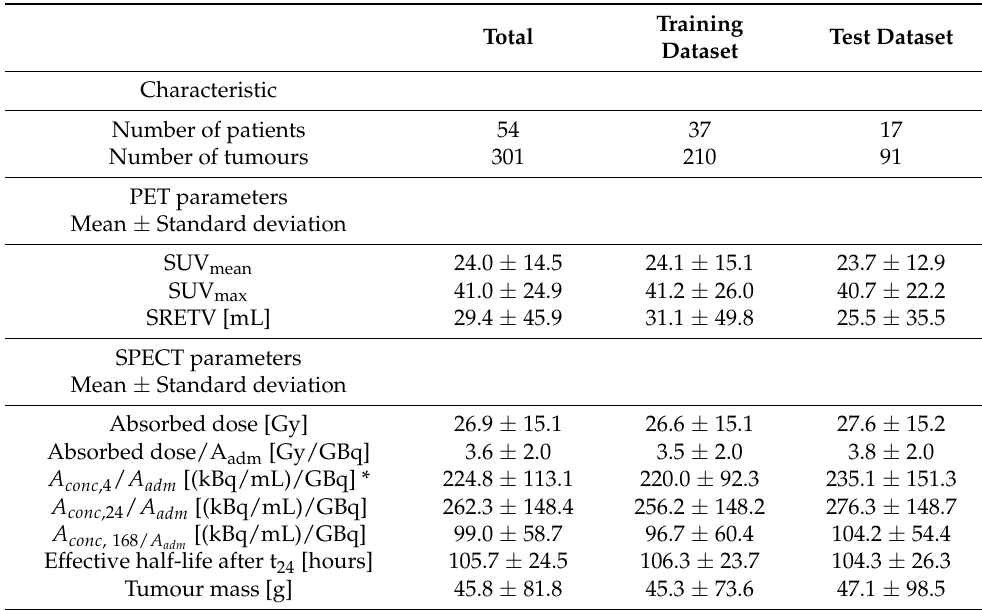
Training Test Dataset Total Dataset